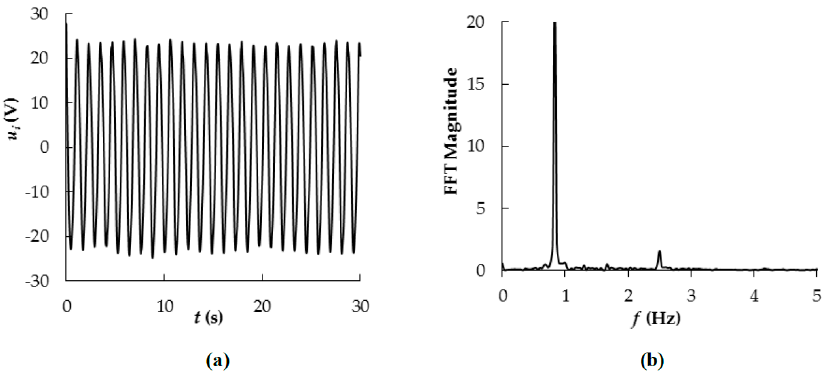
Figure 10. Voltage time histories and frequency spectra for ζ total = 0.284 at U r = 12.23 ( a ) Instantaneous voltage; ( b ) Frequency spectrum.